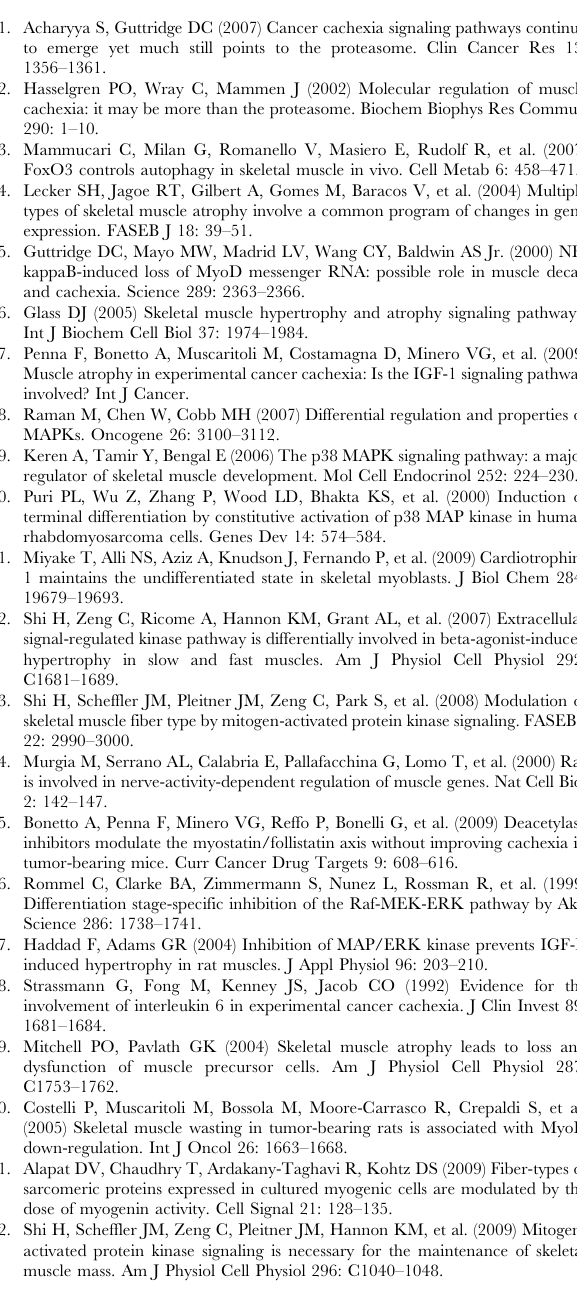
Figure S4 Myogenin is hyperphosphorylated in the GSN of C26-bearing mice. Myogenin expression assayed in C (n =2) and TB mice (n= 2) on 30 m g of GSN cytosolic proteins, incubated (30 9 , 37 u C) in 2 mM MnCl2, 50 mM HEPES pH 7.5, 0.1 mM EGTA, 5 mM DTT, in the presence or in the absence of lambda phosphatase (PPase; 400 U), and heat-denaturated in sample- loading buffer. Western blotting conducted as described in Materials and